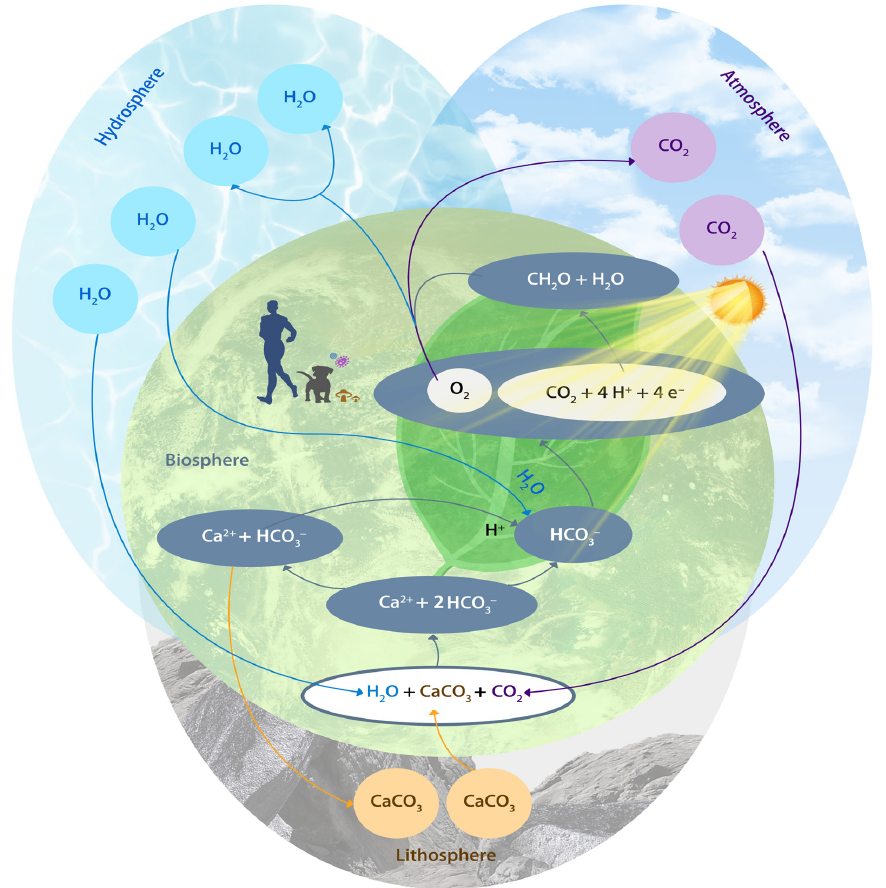
Figure 1. Karstification–photosynthesis coupling processes and their role in the water–carbon balance in nature. Carbonate rocks (lithosphere) are dissolved under the action of water (hydrosphere) and carbon dioxide (atmosphere) to form Ca 2+ and bicarbonate (biosphere) (carbon sink process). Ca 2+ combines with bicarbonate to precipitate calcium carbonate (CaCO 3 ) into the lithosphere (carbon source process). Plants split bicarbonate and water to release oxygen and carbon dioxide, then assimilate carbon dioxide to form carbohydrates (CH 2 O) (biosphere) (carbon sink process). Finally, organisms utilize oxygen to decompose carbohydrates into carbon dioxide that enters the atmosphere, and water that enters the hydrosphere (carbon source process). seems to reflect the ability of carbonate rock to capture CO 2 . However, due to the high sulting high temporal and spatial heterogeneity of bicarbonate, the application of the car- is limited [11]. Even if the dissolution amount of carbonate can be determined by the car- bonate-rock-tablet test, this can only partially reflect the weathering of carbonate (appar- ent karst carbon sink). In addition, even if changes in the bicarbonate of karstic catchments can be determined via the solute load method or the maximum potential dissolution method, this only partially reflects the instantaneous apparent karst carbon sink capabil- ity. The ability of terrestrial and aquatic plants to “intercept” (assimilate) bicarbonates, i.e., net karst carbon sinks, is difficult to obtain using these methods. However, the amount